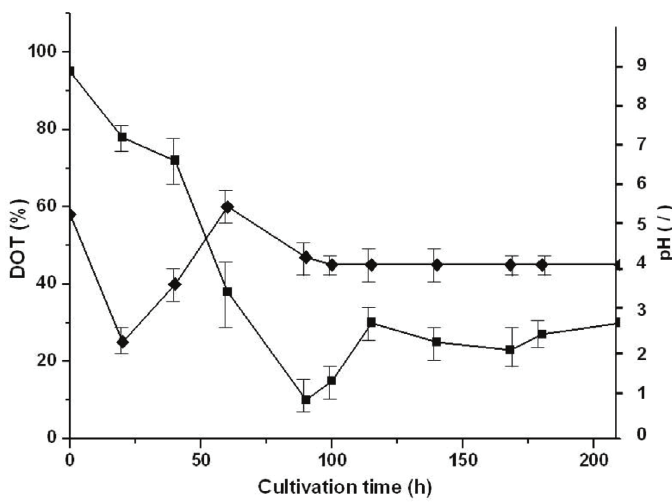
Fig. 3 – Batch cultivation of Ganoderma lucidum  pH; ■ dissolved oxygen tension (DOT) expressed in per- centage of saturation pressure